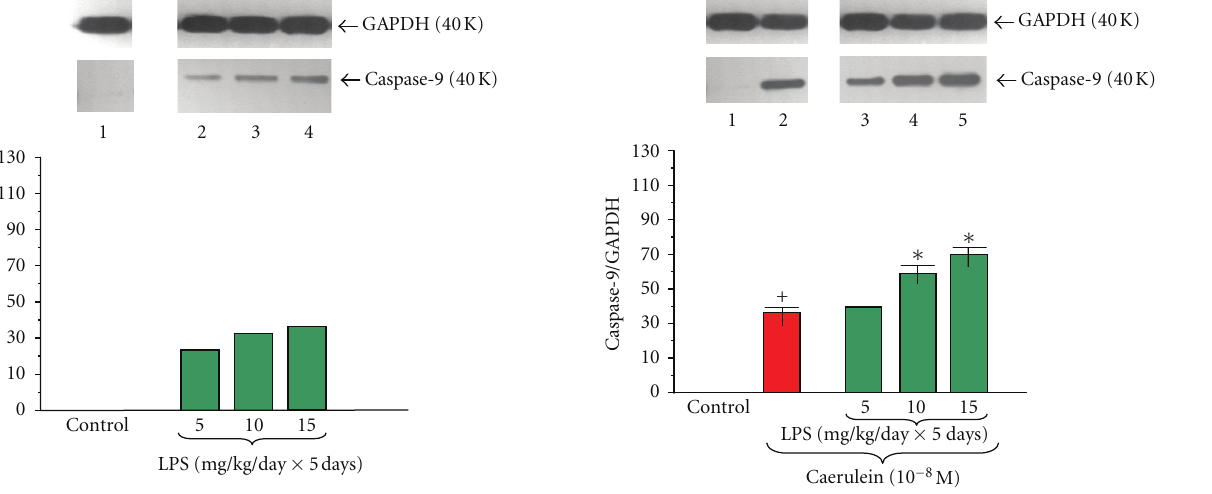
Figure 11: Western blot analysis of proapoptotic initiator caspase- 9 protein level in the adult rat pancreatic acinar cells under basal conditions (lane 1), stimulated in vitro by caerulein at the dose of 10 − 8 M (lane 2), treated in the infant animals by lipopolysaccharide ( Escherichia coli ) at the doses of 5mg/kg/day × 5 days + caerulein 10 − 8 M (lane 3), 10 mg/kg/day × 5 days + caerulein 10 − 8 M (lane 4), and 15 mg/kg/day × 5 days + caerulein 10 − 8 M (lane 5) after 5 hours of incubation. Cross indicates significant ( P < 0 . 05) change, as compared to the control group. Asterisk indicates significant ( P < 0 . 05) change, as compared to the value obtained from the rats treated by increasing doses of LPS (10 or 15mg/kg/day × 5 days) in combination with caerulein (10 − 8 M), as compared to the caerulein (10 − 8 M) alone stimulation. The blots were stripped and probed with GAPDH to document equal protein loading. All presented results were obtained in 4 consecutive experiments and are representative of the observed